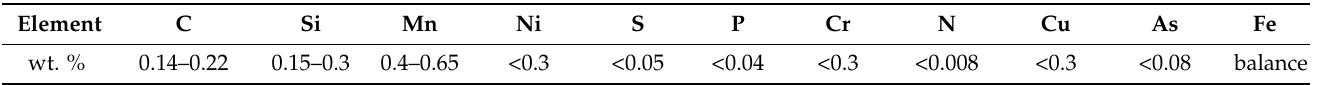
Table 1. Elemental composition of St3